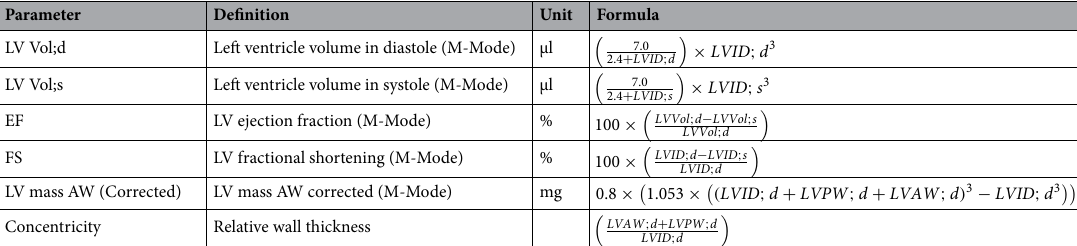
Table 3. Calculations short-axis